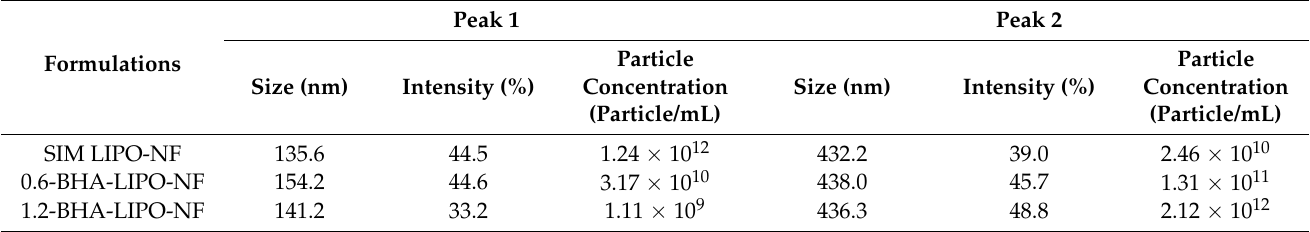
Table 3. MADLS and particle concentration results of the dissolved LIPO-NF samples.